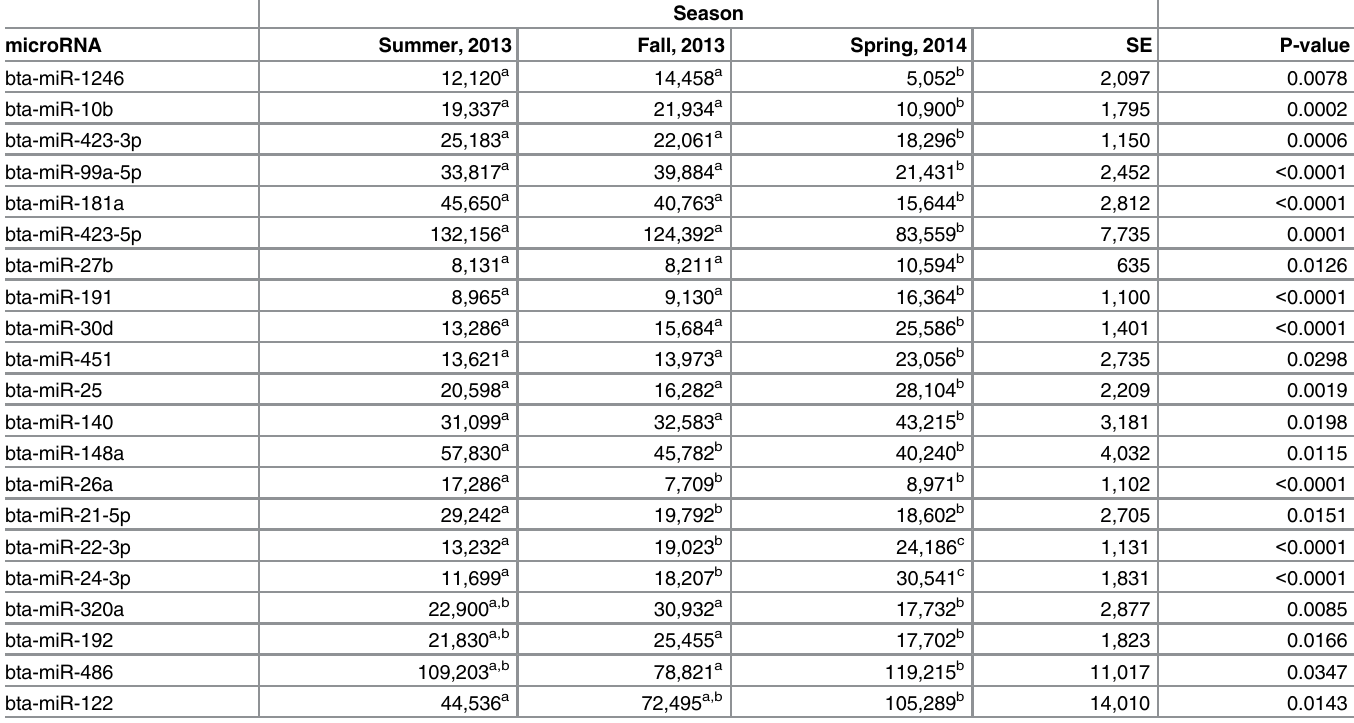
A total of 21 microRNAs were associated with season (Table 3). Six microRNAs (bta-miR- had the fewest copy numbers ( P < 0.01) in the spring, 2014, when compared with copy num- bers produced during summer and fall, 2013. There were six microRNAs (bta-miR-27b, bta- miR-191, bta-miR-30d, bta-miR-451, bta-miR-25, and bta-miR-140), that had the greatest number of copies ( P < 0.05) in the spring, 2014, when compared with summer and fall, 2013. Three microRNAs (bta-miR-148a, bta-miR-26a, and bta-miR-21-5p), had the greatest copy numbers ( P < 0.02) during the summer, 2013, when compared to the fall, 2013 and spring, 2014. Bta-miR-22-3p and bta-miR-24-3p had the fewest number of copies in summer, 2013, an intermediate number of sequences in fall, 2013, and the greatest number in spring, 2014 ( P < 0.0001). Bta-miR-320a and bta-miR-192 had the greatest number of copies during fall, 2013, while spring, 2014, had the fewest ( P < 0.02). Bta-miR-486 had the fewest counts during fall, 2013, and the highest in spring, 2014 ( P = 0.0347), while bta-miR-122 had the lowest in sum- mer, 2013, and the highest in spring, 2014 ( P = 0.0143). Table 3. MicroRNA, normalized mean by season, standard error (SE), and their association